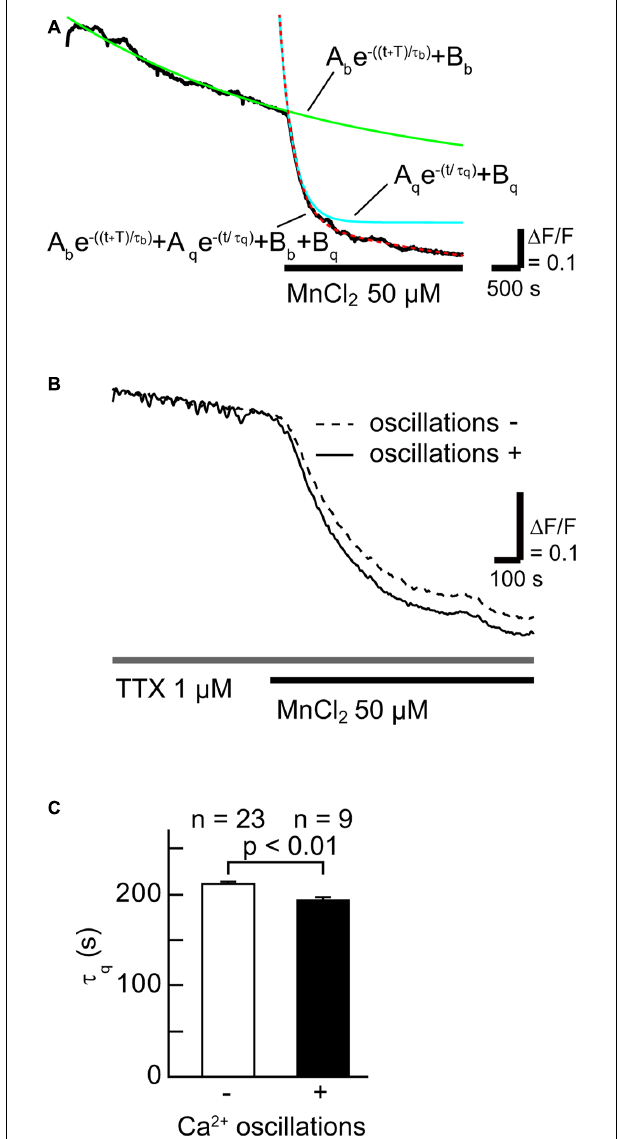
FIGURE 2 | The rate of Ca 2 + influx in neurons with slow Ca 2 + oscillations was faster than in those without slow Ca 2 + oscillations. (A) A typical time course of Mn 2 + quench of Fura-2 LR fluorescence (black line). To evaluate the rate of Ca 2 + channel opening, the fluorescence decay was fitted with the double-exponential function (dotted red line) consisting of a fluorescence bleaching component (green line) and a quenching component (blue line). (B) Typical time courses of Mn 2 + quench in neurons with (solid line) and without (broken line) slow Ca 2 + oscillations. (C) Summary data of the time constant of the quenching component ( τ q ) in neurons without (open) and with (filled) slow Ca 2 +